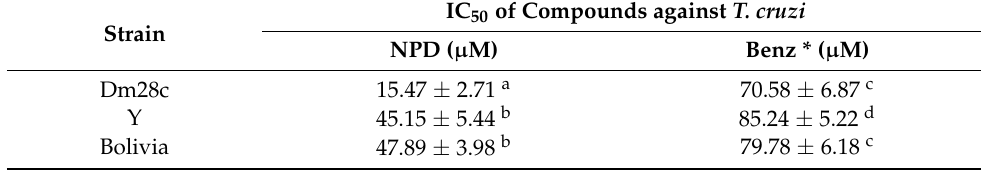
Table 2. IC 50 of DETC nanoparticles against different strains of T. cruzi after 24 h of exposure. Results are presented as mean ± standard deviation in an independent triplicate system and for the statistical analysis of the ANOVA test, together with Tukey’s post hoc test, in which different letters indicate statistically significant differences at p < 0.05.